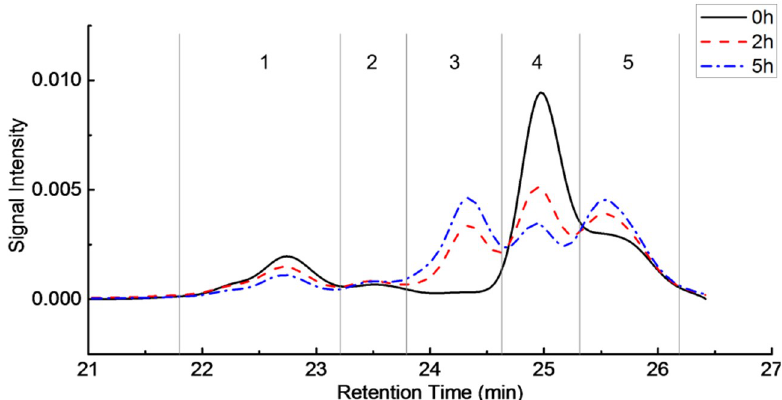
Figure 2. Molecular size distribution of water-soluble polysaccharides in enzyme treated longan juice for 2 h and 5 h, as compared with untreated longan juice (0 h).